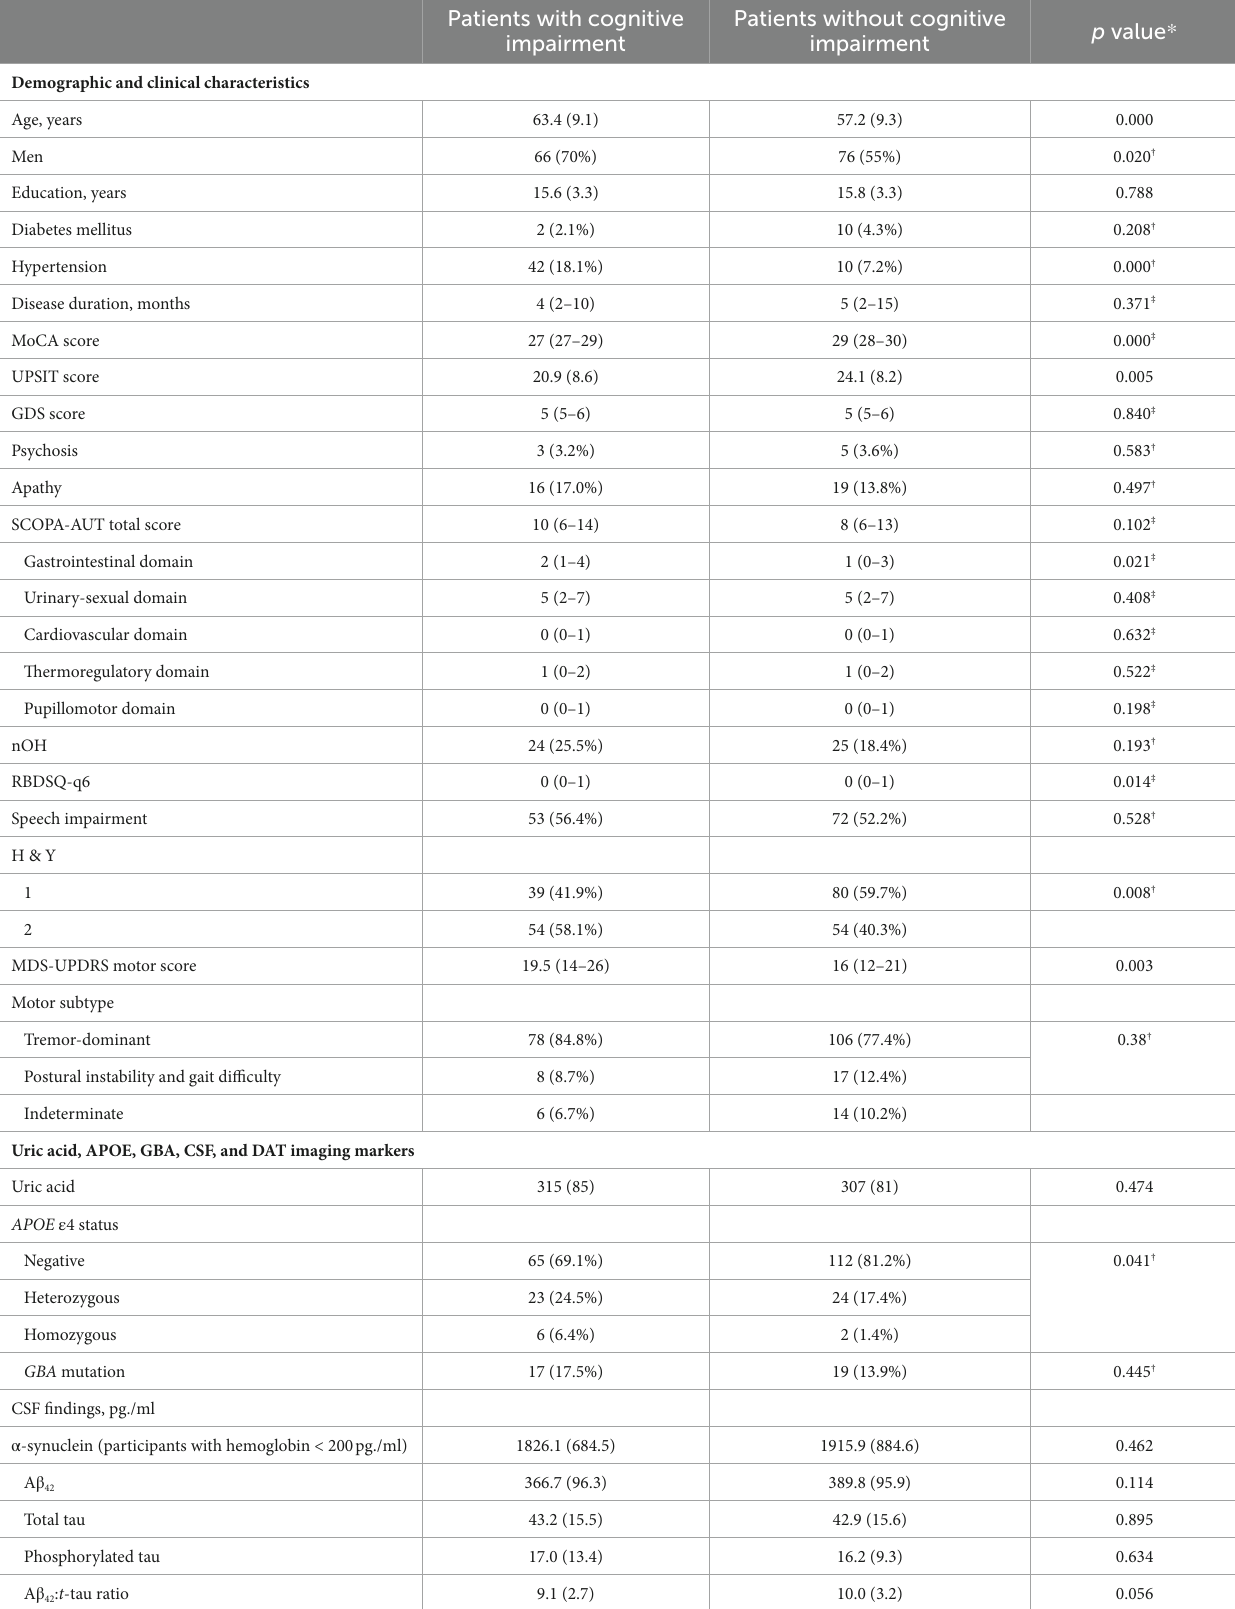
TABLE 1 Baseline characteristics and biomarkers of the patients with newly diagnosed Parkinson’s disease (less than 2 years) with or without cognitive impairment developed during the 5-year follow-up.